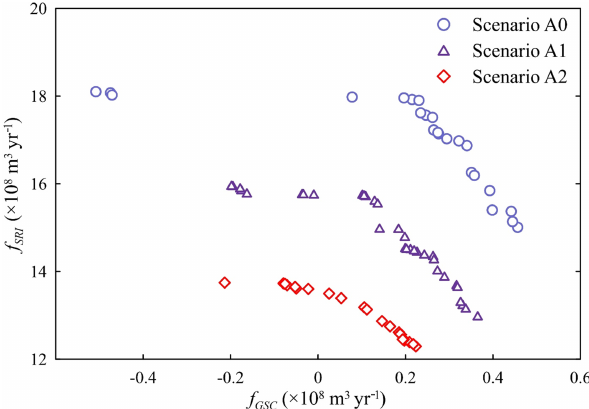
Figure 13. Non-dominated fronts of scenarios A0, A1, and A2 be- tween the objectives f GSC vs. f SRI